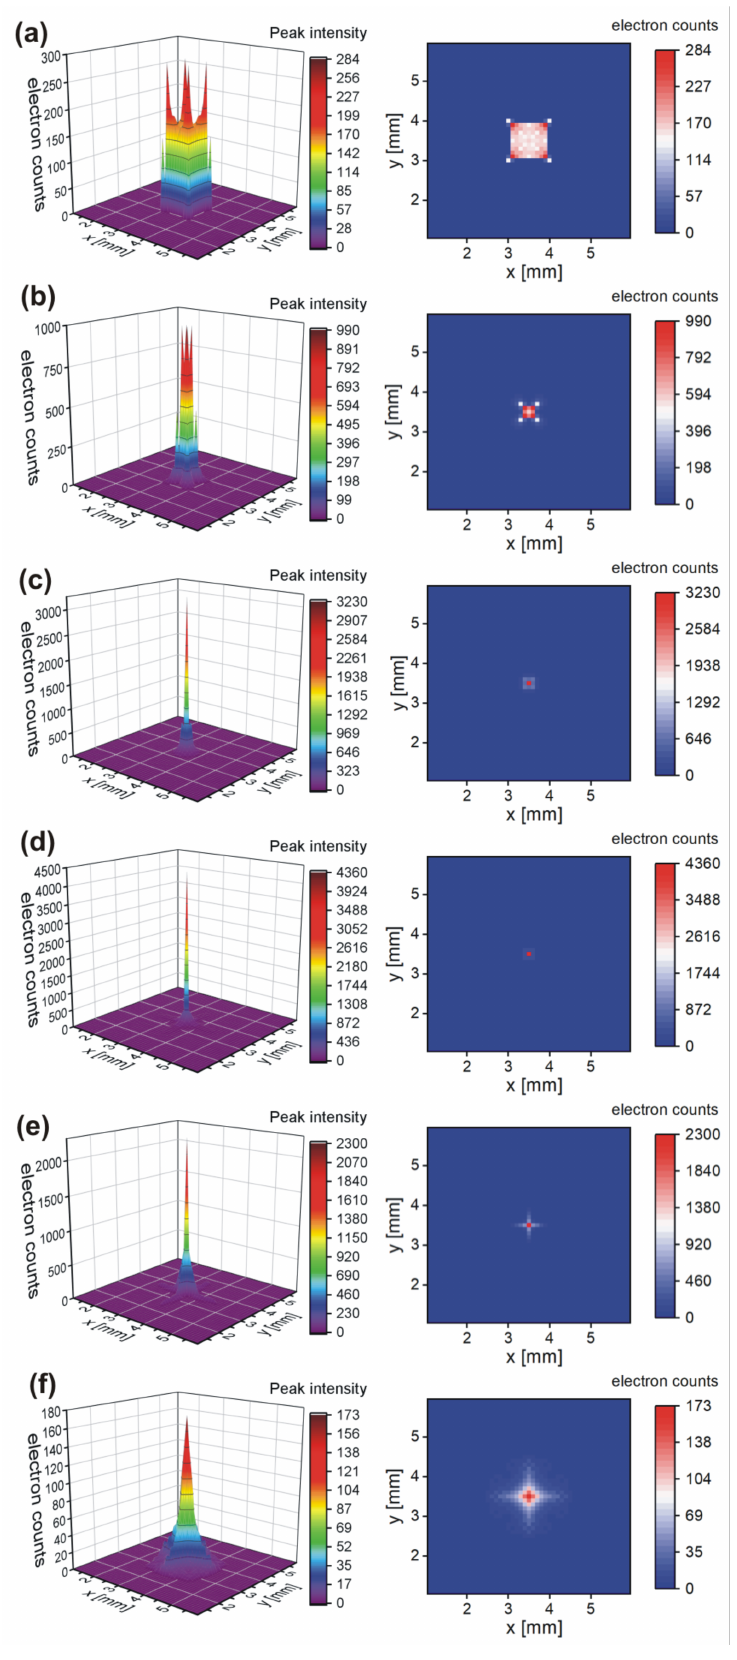
Figure 4. Three-dimensional plots and heat maps of the beam spot at the anode for different focusing voltages: ( a ) U F = − 1000 V; ( b ) U F = − 1500 V; ( c ) U F = − 1700 V; ( d ) U F = − 1840 V; ( e ) U F = − 1900 V; ( f ) U F = − 2100